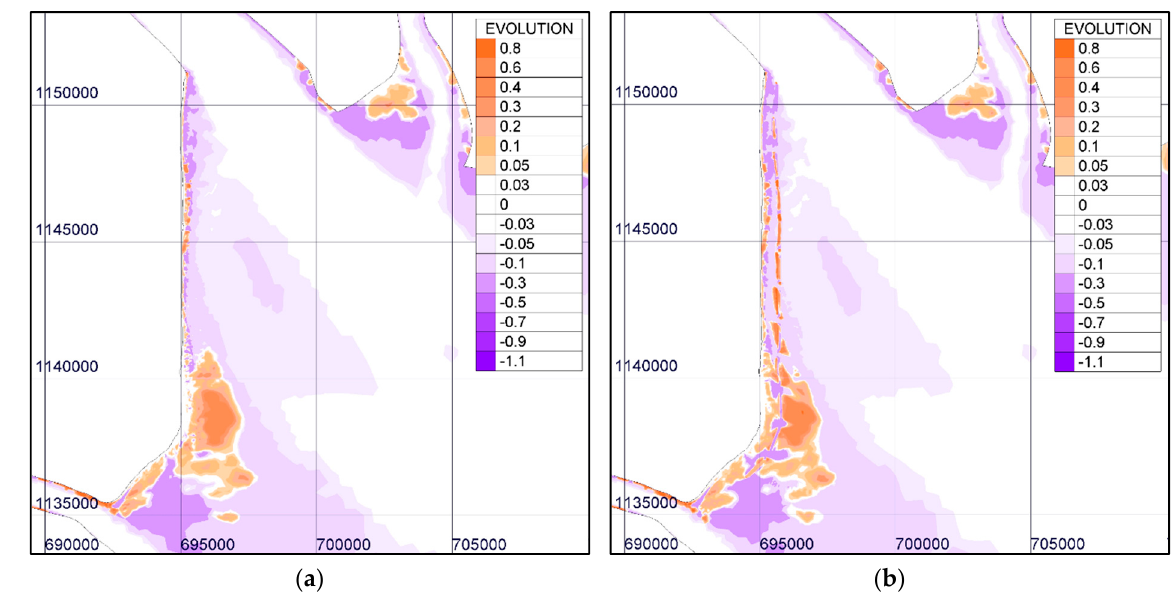
Figure 19. Morphological changes by sandbars for one month in the NE monsoon (January 2014) provided by TELEMAC: ( a ) at 01 January 2014, ( b ) at 31 January 2014. Table 7. Impact comparison of breakwaters with sandbars in January 2014 (NE winds) by TE ‐ LEMAC ‐ 2D.